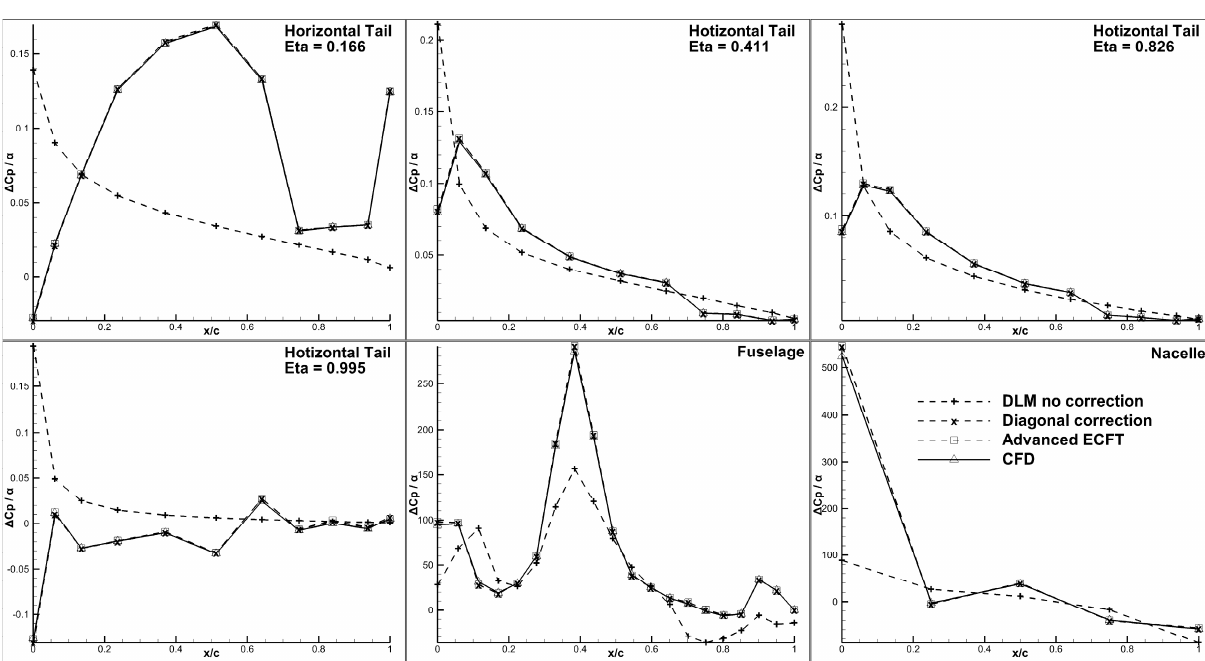
Figure 7. Rigid Δ Cp for a unit α in the horizontal tail, fuselage, and nacelle component.